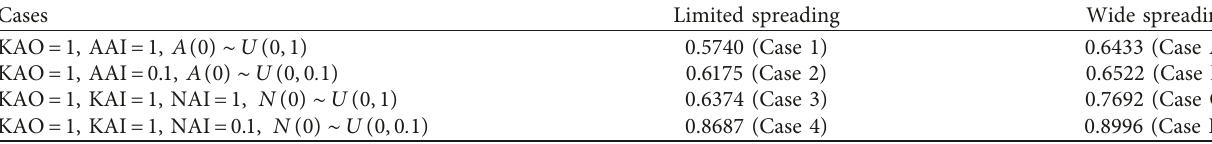
Table 4: The results of cases which key agents guiding the public opinion under different scenes. Cases